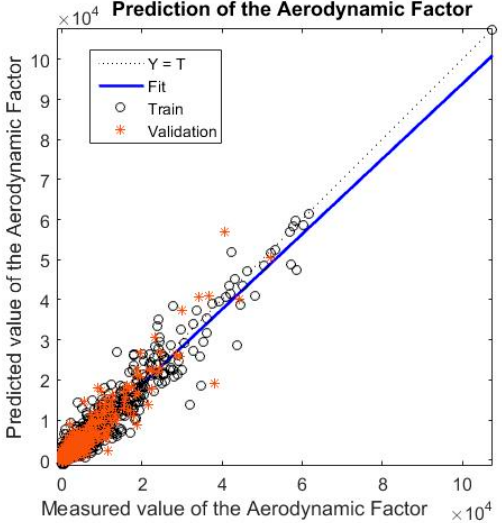
Figure 7. Regression plot for the prediction of the aerodynamic predictor over the segments by the NN on the training set and validation set of Dataset 2.